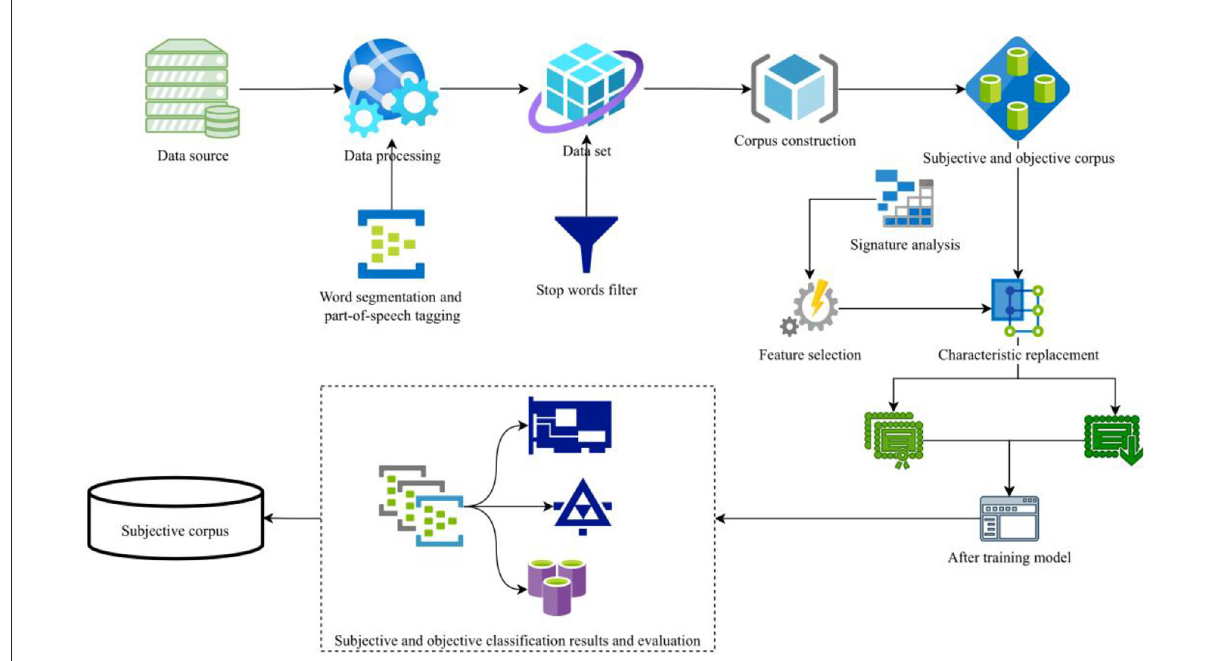
FIGURE1 Subjective and objective online community identification scheme.